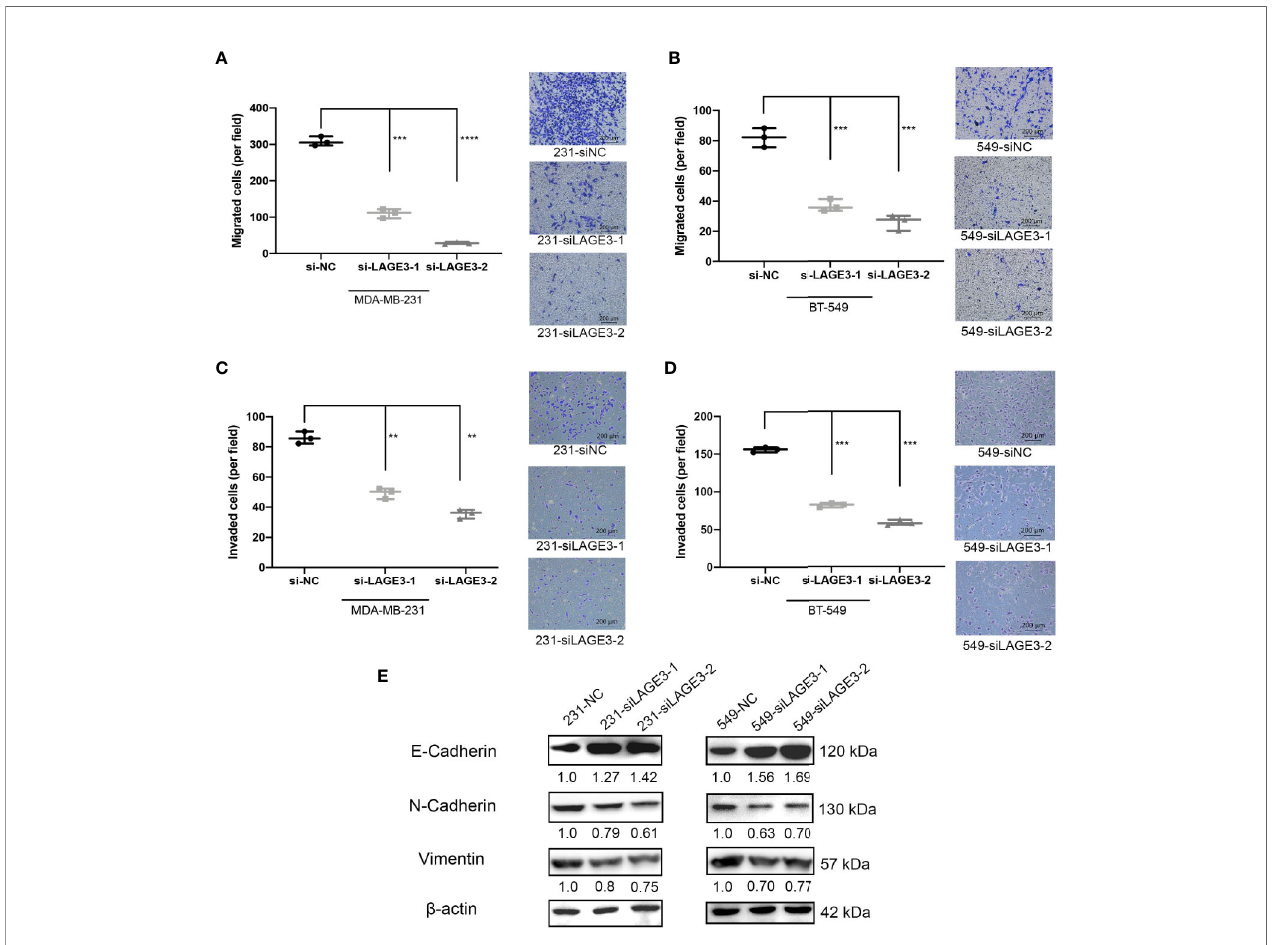
FIGURE 9 | LAGE3 affected the migration and invasion of TNBC cell lines via EMT pathways. (A – D) The number of migrated or invaded cells in different groups as determined Transwell (scale bar = 200 m m). (E) The of EMT-related proteins in si-NC or si-LAGE3 cells as determined by Western blotting assay. All experiments were repeated at least three times. Group data were compared with unpaired Student ’ s t-test (two-tailed). EMT, epithelial – mesenchymal transition. **p < 0.01; ***p < 0.001; ****p <